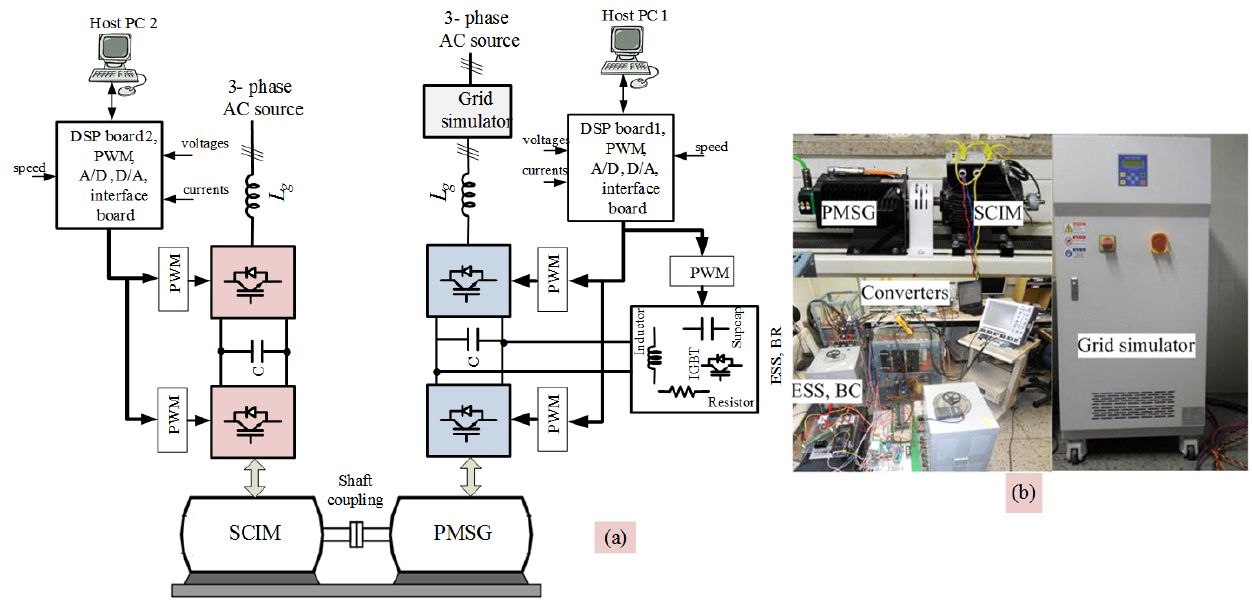
Figure 8. Experimental setup. ( a ) Configuration. ( b ) Apparatus. Table 4. Specifications of PMSG, ESSs, and